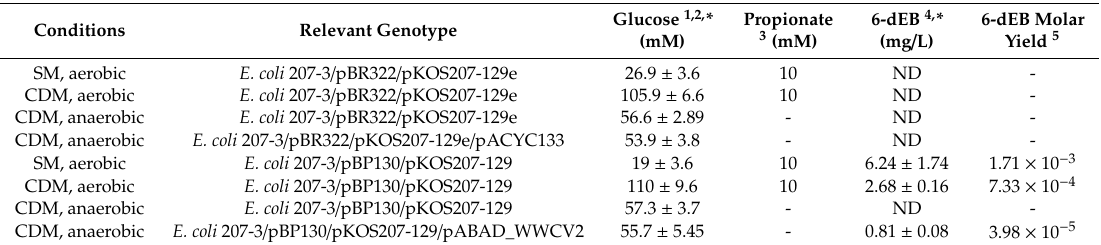
Table 1. 6-dEB production by recombinant E. coli